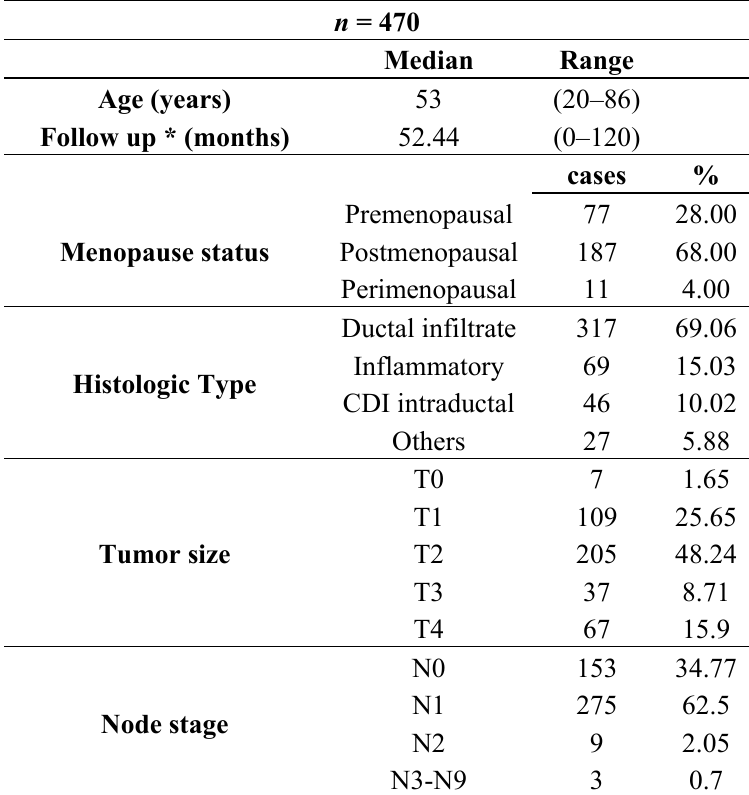
Table 1. Characteristics of breast cancer patients ( n =